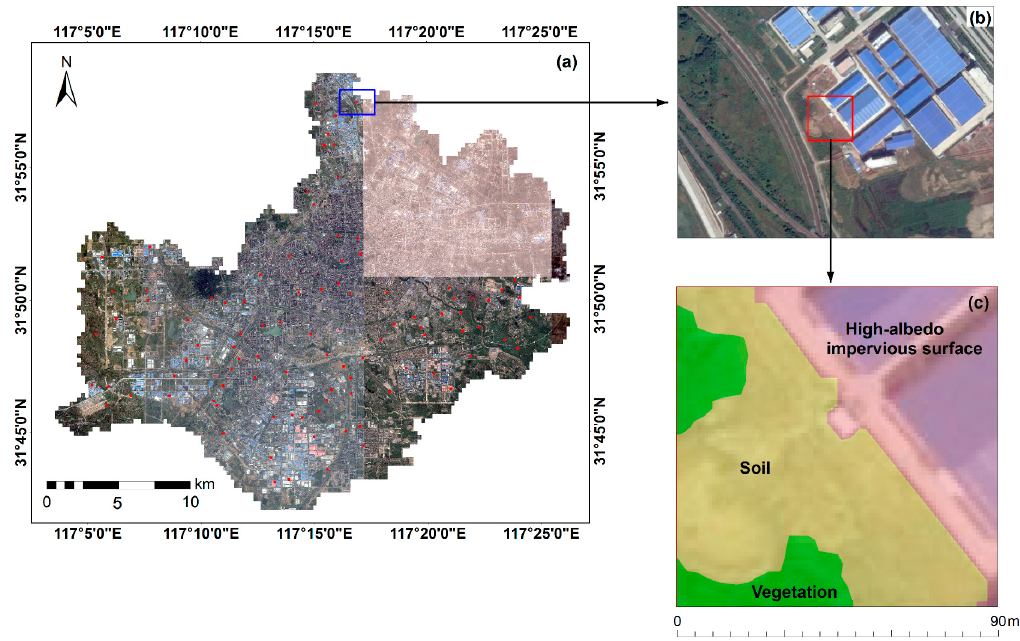
Figure 6. ( a ) A 2 m resolution satellite image of the study area on 2 October 2013; ( b ) one of 100 randomly distributed validation samples (show in red rectangle) on the Google Earth image; ( c ) interpretation of one validation samples.